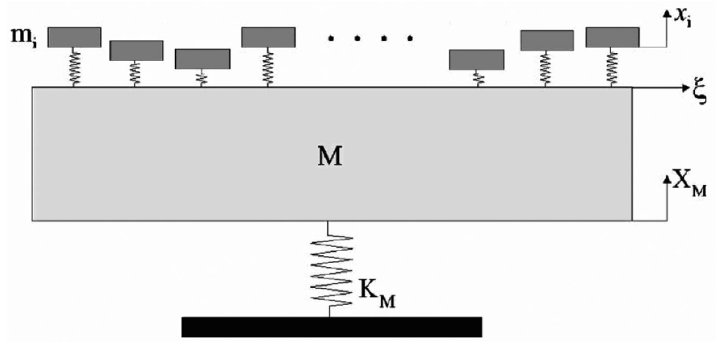
Fig. 1. A Schematic description of a primary deformable structure (M) and attached set of Oscillators (m i )